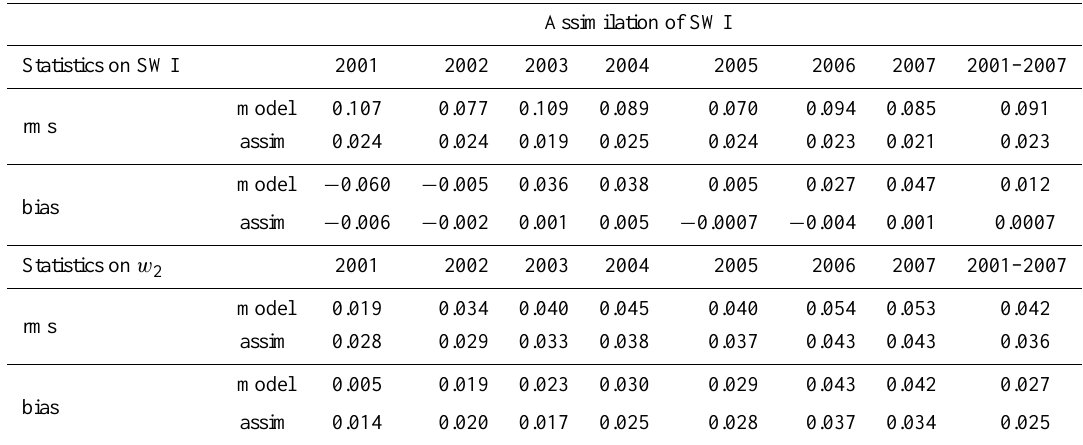
Table 4. Statistics on SWI and w 2 (m 3 m − 3 ) before and after assimilation of soil wetness index SWI, year by year and for the 7-year period (2001–2007).